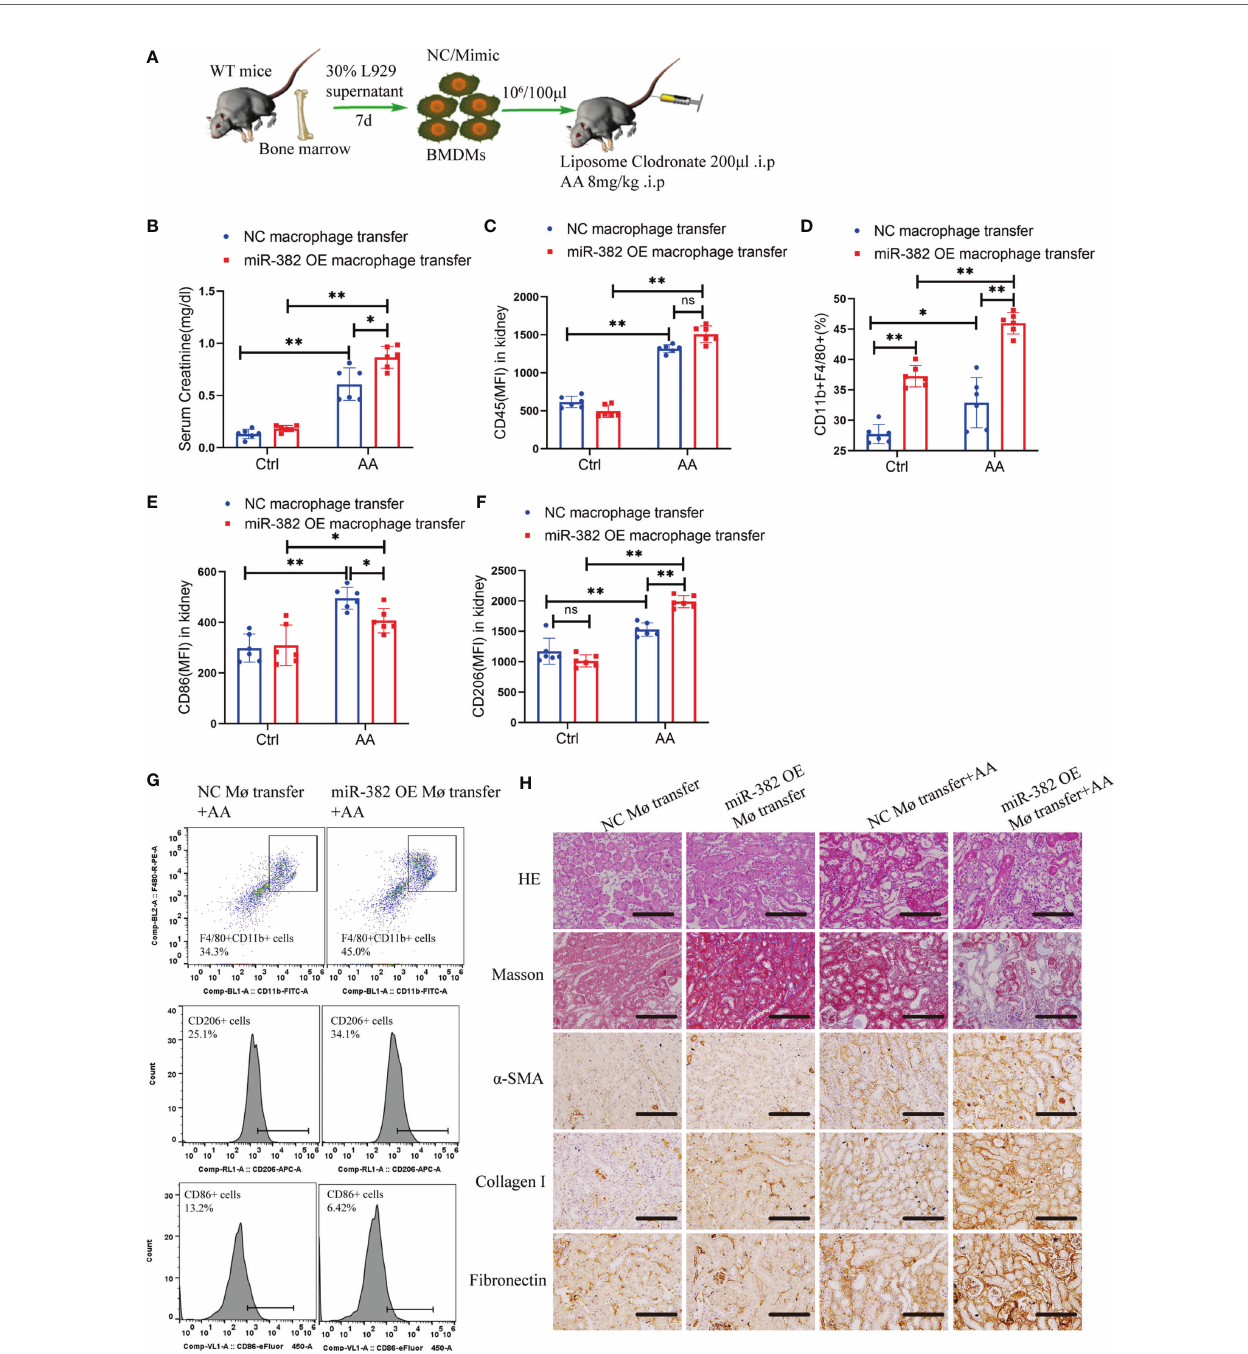
FIGURE 4 | MiR-382 OE BMDMs transfer augmented AA-induced CKD. (A) Strategy of macrophages transfer in mice: bone marrow was acquired from mice and further induced with 30% L929 supernatant and derived into BMDMs. NC or miR-382 mimic were separately transfected into BMDMs. Macrophages were depleted with LC via intraperitoneally injection (200 m l) in mice. AA was administrated at a dosage of 8mg/kg in mice. Then, BMDMs were counted and suspended in PBS (107/ml) and injected with 100 m l via tail vein and repeated every four days. (B) Serum creatinine of mice between NC macrophage transfer and miR-382 OE macrophage transfer groups. (C-F) MFI of CD45, percentage of CD11b+F4/80+, MFI of CD86 and MFI of CD206 between NC macrophage transfer and miR-382 OE macrophage transfer groups. (G) Representative images of CD11b+F4/80+ macrophages, CD206+ M2 macrophages and CD86+ M1 macrophages between NC macrophage transfer and miR-382 OE macrophage transfer groups. (H) Representative images for HE staining, Masson staining, IHC for a -SMA, Collagen I and Fibronectin in renal sections among these groups. Scale bars, 200 m m. n=6 mice each group. *P < 0.05; **P < 0.01; ANOVA. ns, no signi fi